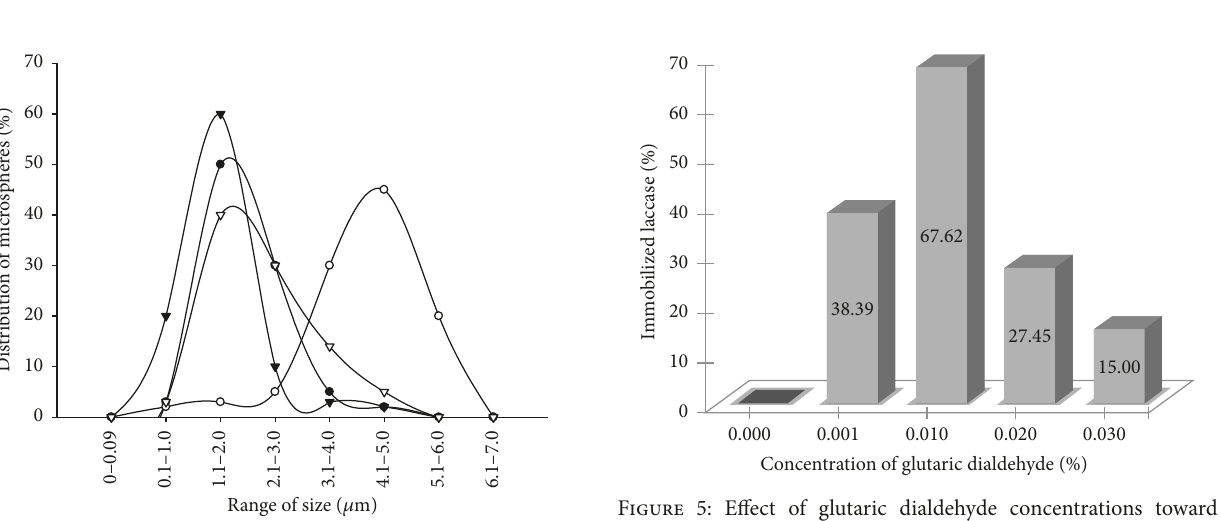
Figure 5: Effect of glutaric dialdehyde concentrations toward enzyme binding